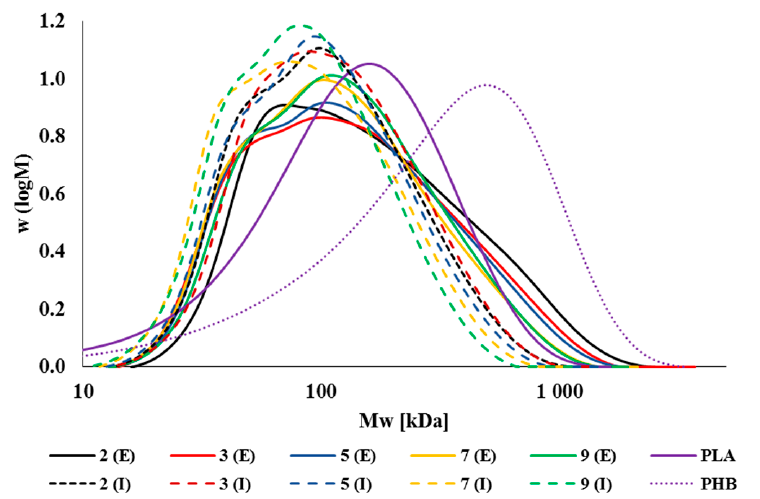
Figure 5. Molar mass distribution of individual processing cycles of experimental and industrial types of the NONOILEN ® 3D 3056-2 material.